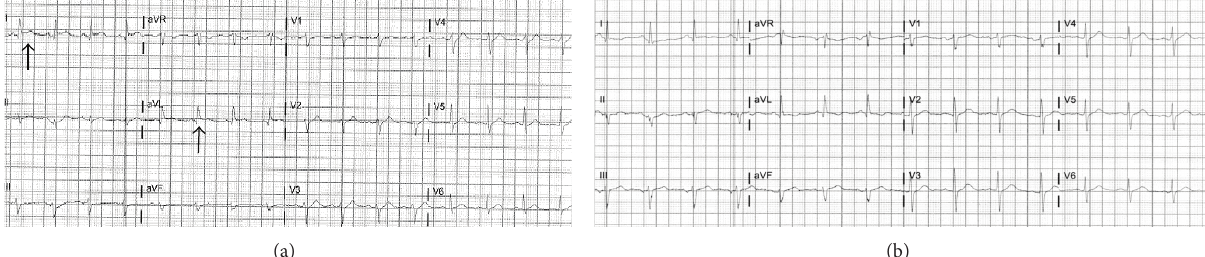
Figure 1: (a) EKG during chest pain-ST elevation in leads I and aVL. (b) Normal EKG after two days.